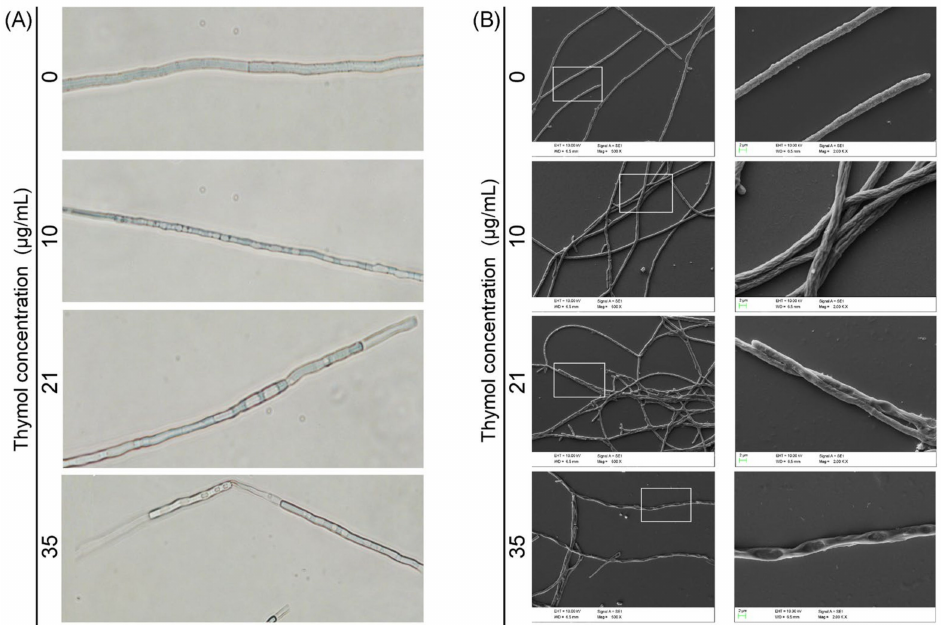
Figure 3. Thymol induced morphological changes of FON mycelia. ( A ) Light microscopic observation of mycelia upon thymol treatment for 24 h. ( B ) SEM observation of mycelia upon thymol treatment for 24 h. Left panel and right penal indicated the magnification of 500 × and 2000 × , respectively.